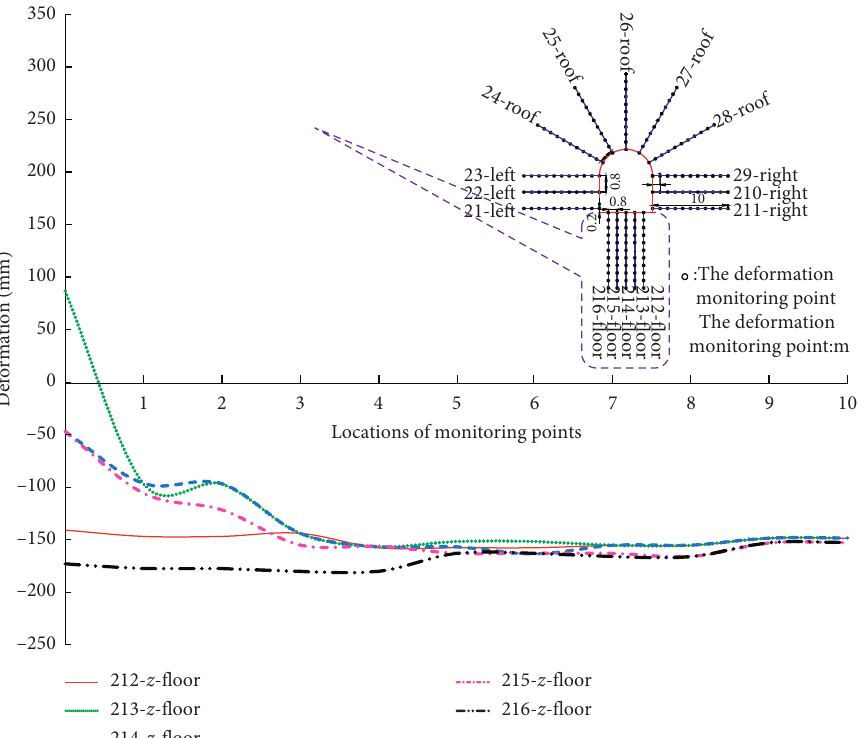
Figure 10: The Z -direction deformation law of the surrounding rock of roadway